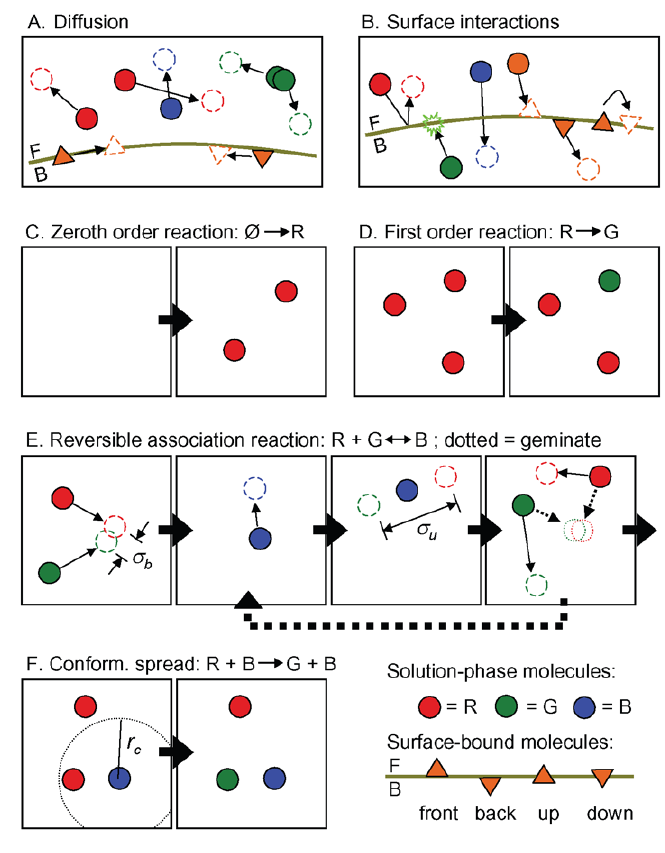
Figure 2. Algorithms used in Smoldyn. The bottom-right panel is a key. The front and back sides of surfaces are noted with ‘F’ and ‘B’, respectively. (A) Diffusion for solution and surface-bound molecules; note that there is no excluded volume. (B) From left to right, interactions between molecules and surfaces are: reflection, absorption, transmission, adsorption, desorption, and surface-state conversion. (C) Zeroth order chemical reaction. (D) First order chemical reaction. (E) In these sequential association and dissociation reactions, a b is the binding radius and a u is the unbinding radius. The last frame shows two possible scenarios, which are the geminate recombination of the dissociation products (dashed arrows) or diffusion of these products away from each other (solid arrows). (F) Conformational spread reaction with interaction distance r c .